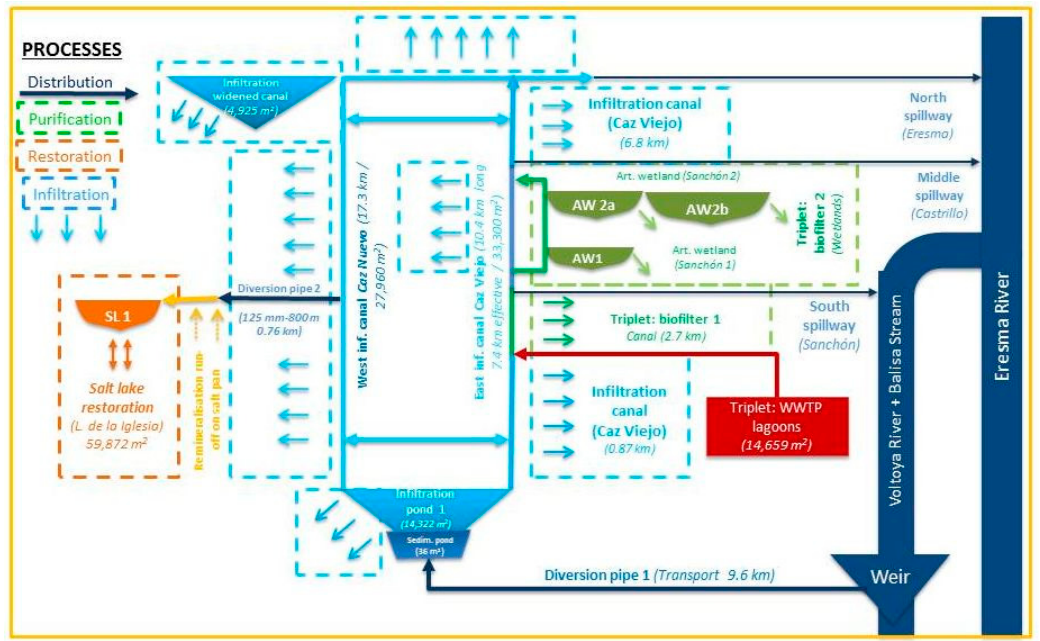
Figure 11. Managed underground water storage for use at annual intervals. Santiuste Basin. MAR devices and functions [15].